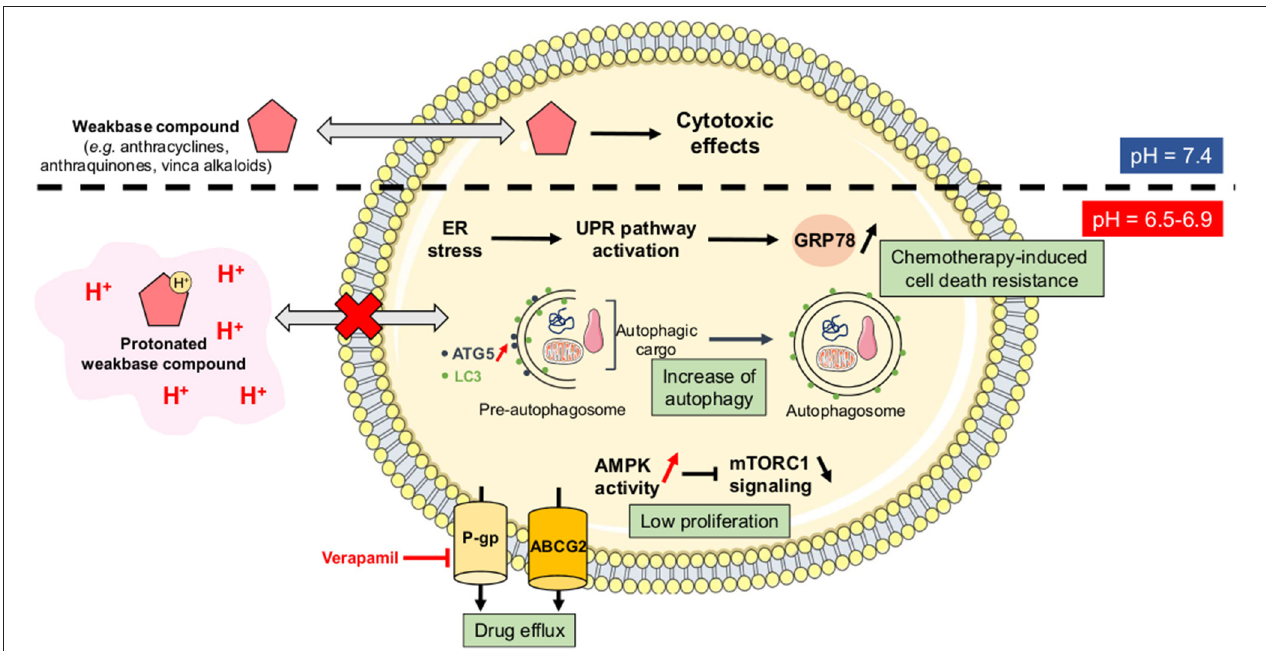
FIGURE 4 | Ion trapping phenomenon and acidosis-induced multidrug resistance. Under acidic conditions, several weak base chemotherapeutic agents become positively charged species and therefore lose their ability to diffuse passively across cellular membranes (the so-called “ion trapping phenomenon”). Tumor acidosis also directly promotes a resistance-sustaining cell phenotype through several mechanisms including the upregulation of glucose-related protein 78 (GRP78) or Bip, an increased autophagic flux, a lower proliferation rate, and an increase of drug efflux capacities via the P-glycoprotein (Pgp) and the ATP-binding cassette protein ABCG2. AMPK, AMP-activated protein kinase; ATG5, autophagy-related protein 5; ER, endoplasmic reticulum; LC3, microtubule-associated protein light chain 3; mTORC1, mammalian target of rapamycin complex 1; UPR, unfolded protein